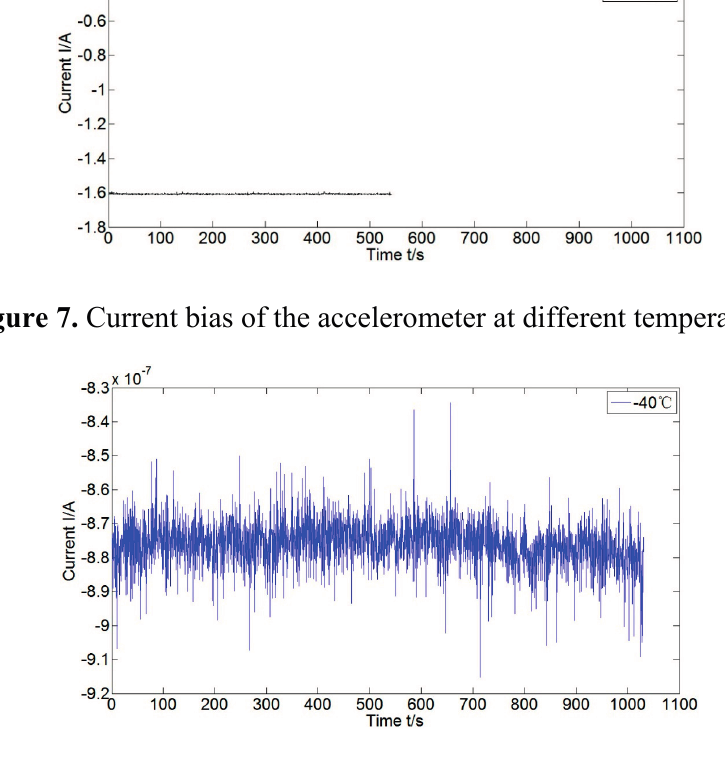
Figure 8. Current bias of the accelerometer at − 40 °C.